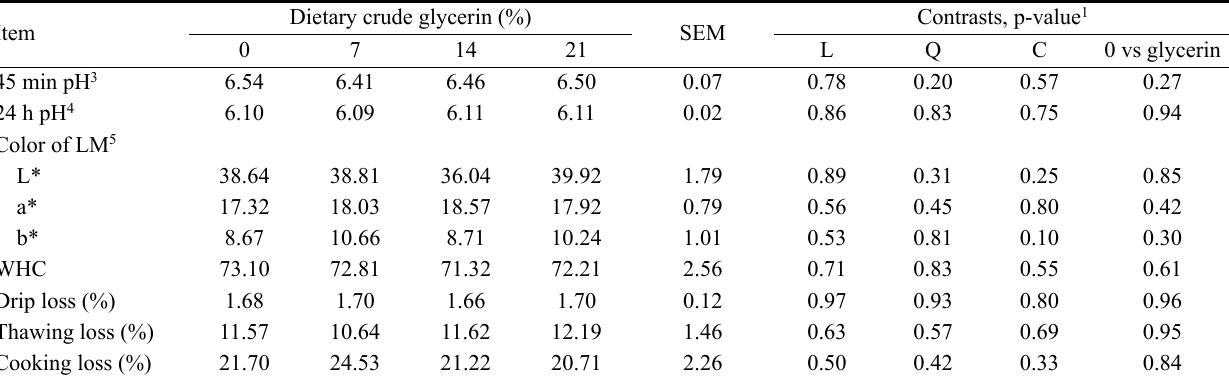
Table 5. Physico-chemical characteristics of beef of steers fed different levels of crude